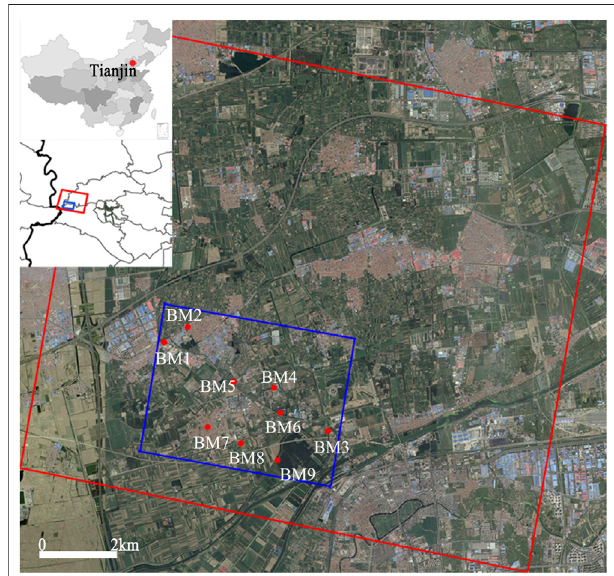
FIGURE 4 | Location of the study area. The two insets depict the geographical location of Tianjin in China and the ground coverage of ASAR (red rectangle) and TSX (blue rectangle). The 22 BMs are used to evaluate the results derived from different methods.